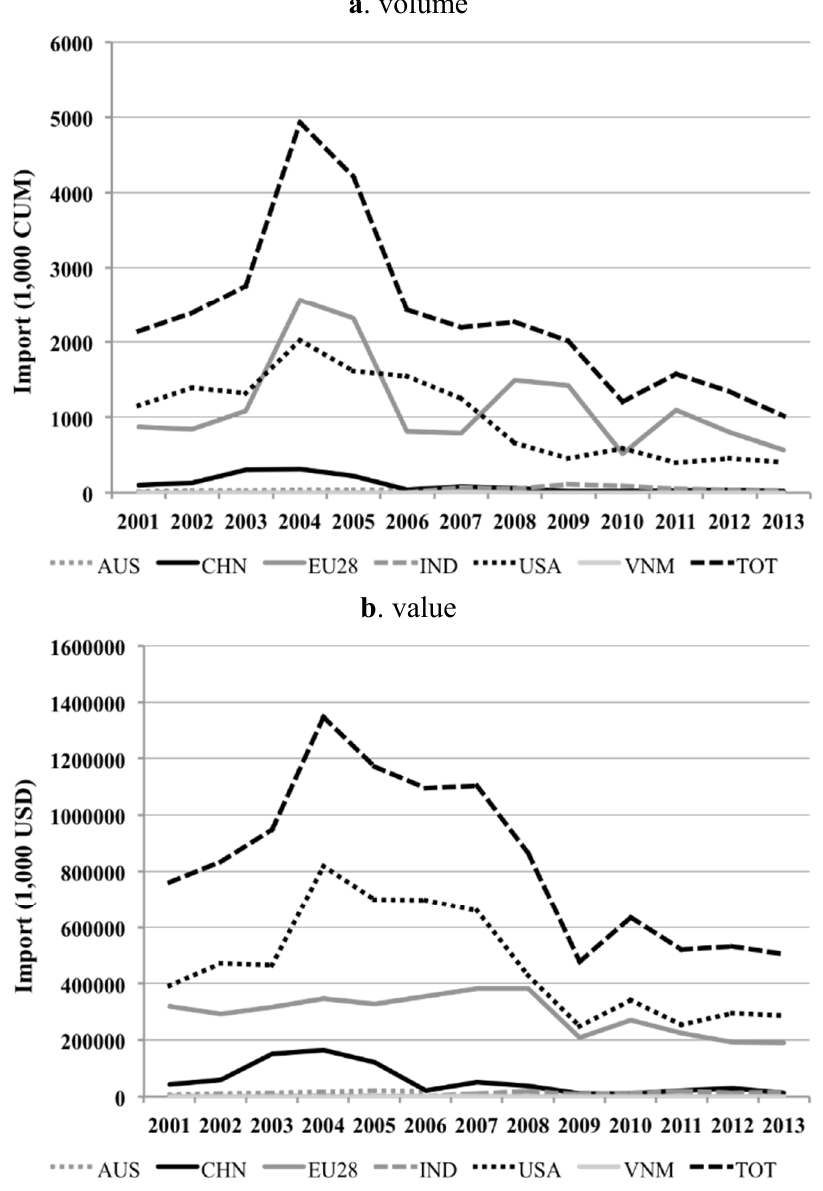
Figure 5. Imports of tropical plywood—in volume ( a ) and value ( b )—by selected countries (2001–2013). Source: own elaboration from